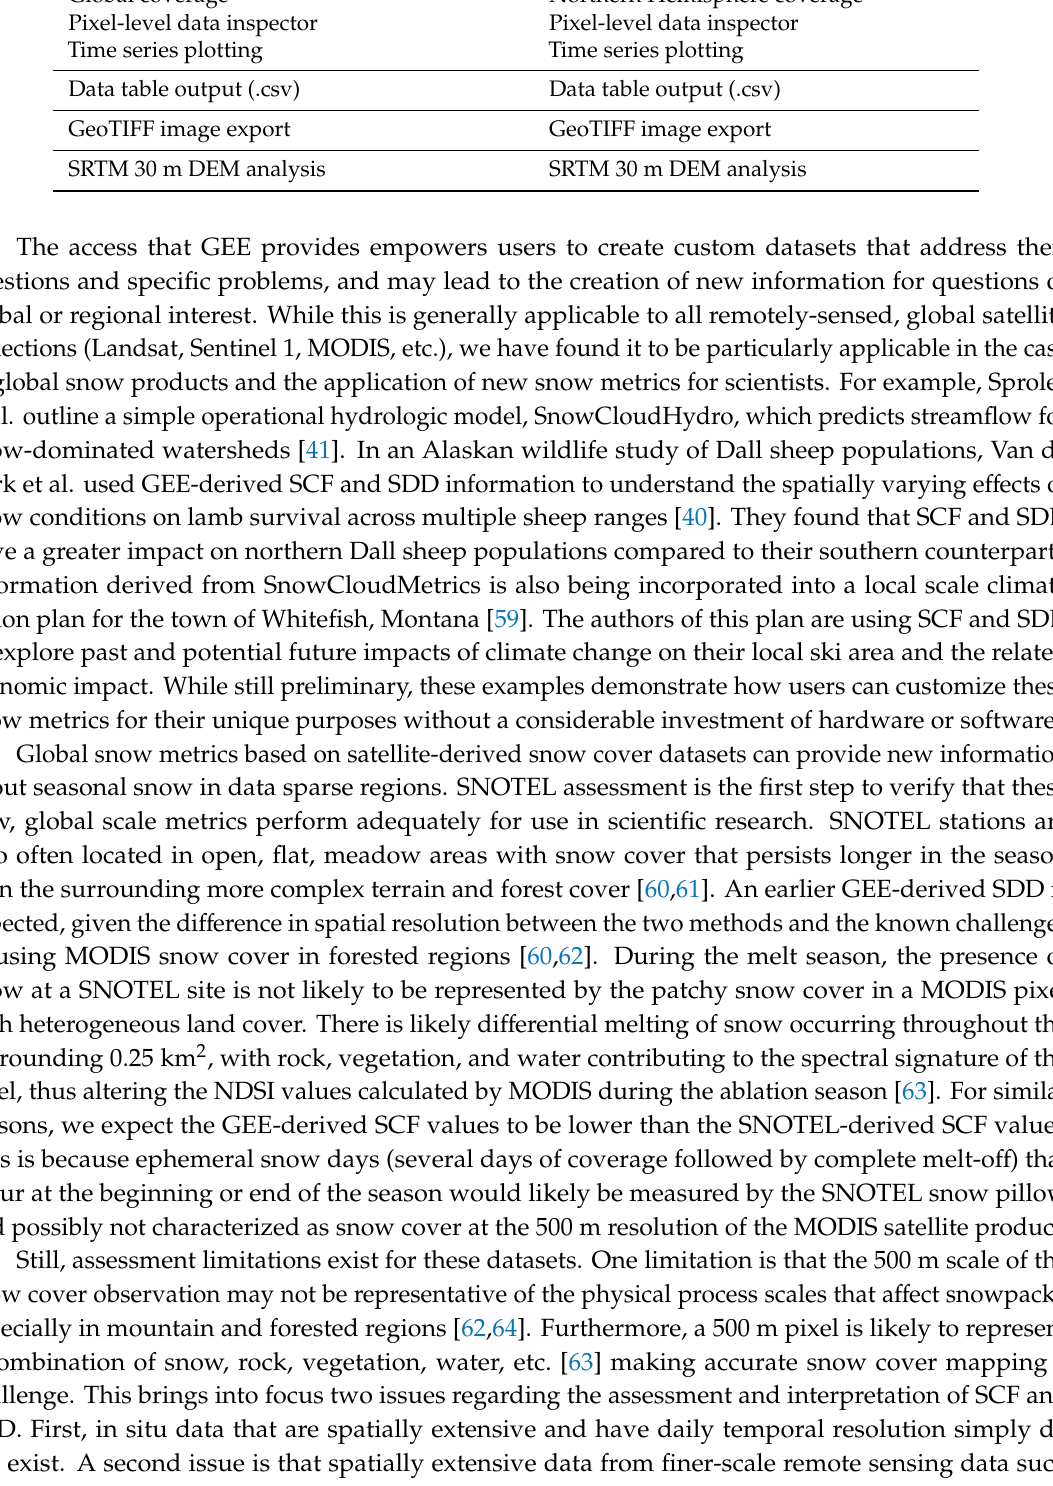
Data table output